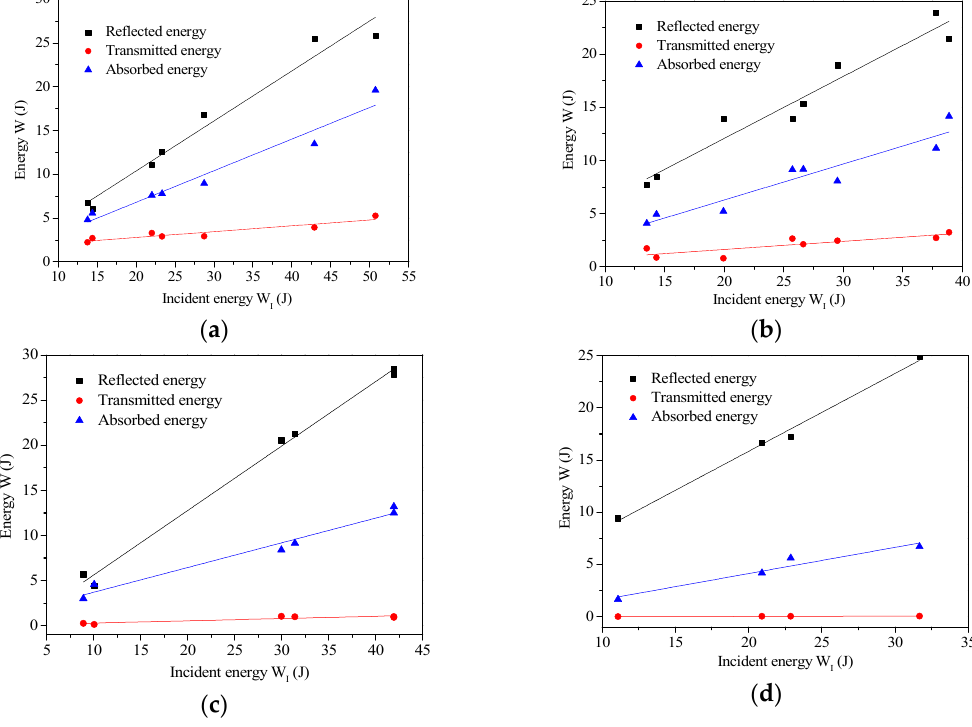
Figure 14. The reflection, transmission, and absorption energy vs. the incident energy, ( a ) 25 °C, ( b ) 200 °C, ( c ) 400 °C, ( d ) 600 °C.